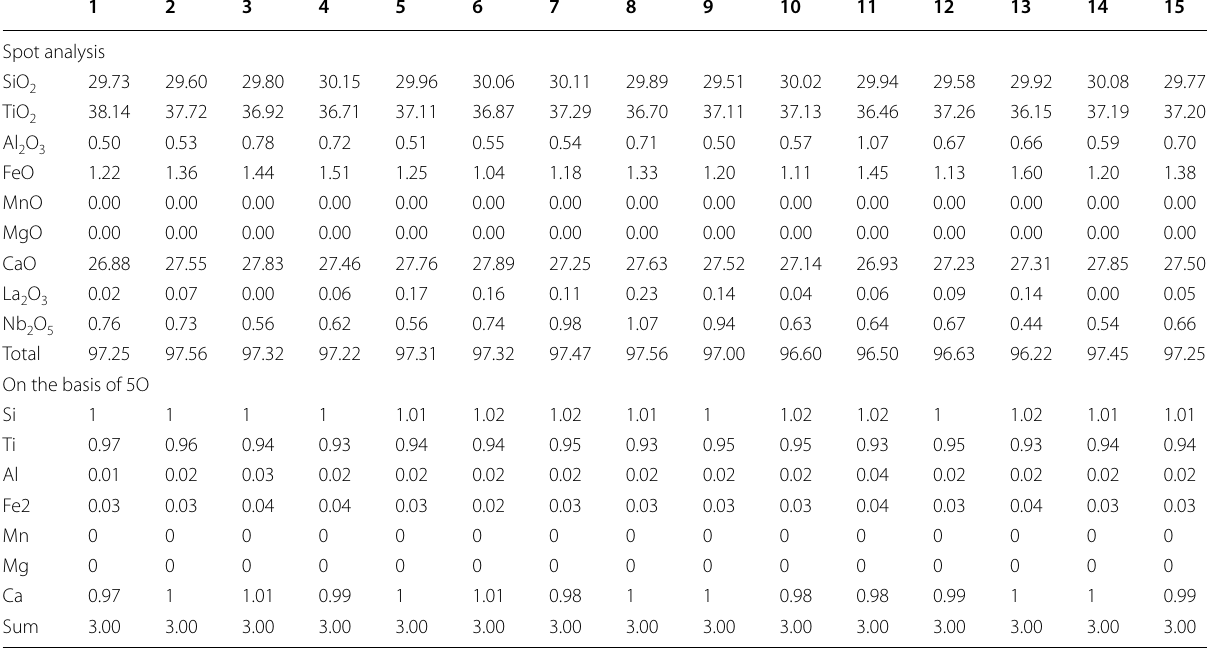
Table 3 Quantitative mineral chemistry